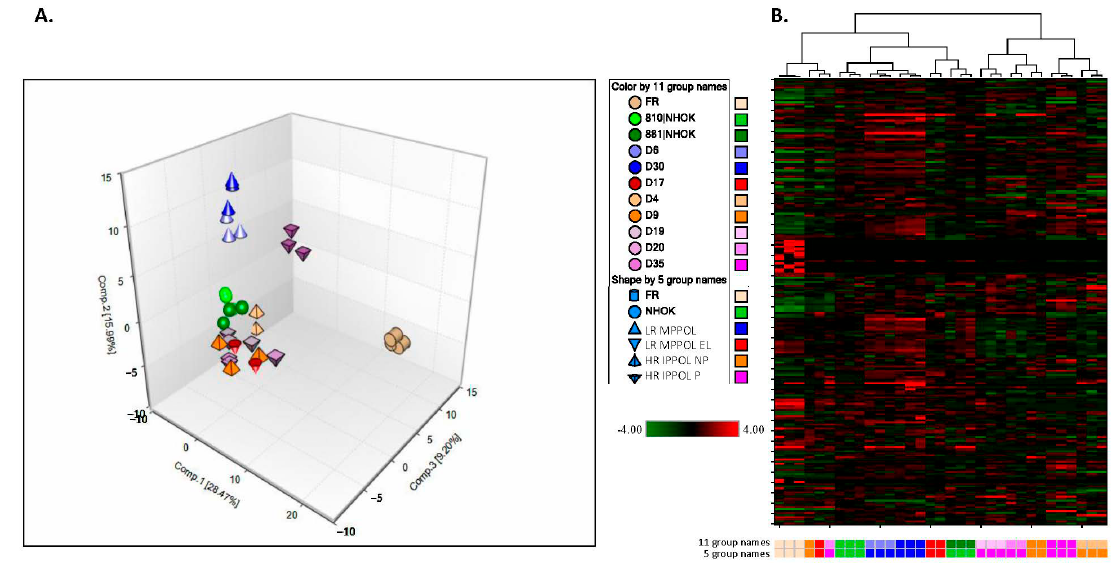
Figure 1. Principal component and cluster analysis of normal and PPOL keratinocyte extracellular metabolites. ( A ) Principal component analysis (PCA)—Low-risk mortal potentially premalignant oral lesion (LR MPPOL—D6 and D30), and rapidly progressing high-risk immortal potentially premalignant oral lesion (HR IPPOL P—D35) media samples exhibited significant separation from the other conditions analysed. The data from the individual cell lines and the fresh media (FR) are colour coded. The symbols represent into which group the individual lines are classified (normal human oral keratinocyte (NHOK—NHOK810 and NHOK881), LR MPPOL (D6 and D30), LR MPPOL extended lifespan (LR MPPOL EL—D17), HR IPPOL non-progressing (HR IPPOL NP—D4 and D9), or rapidly progressing (HR IPPOL P—D19, D20, and D35). The data show a clear separation of the LR MPPOL lines D6 and D30 (blue upright cones, circular base) and the HR IPPOL-P line D35 (dark purple inverted cones, square base) from the other groups and from each other. ( B ) Hierarchical clustering also consistently sorted the majority of the samples by cell class. The colour codes are the same as in (A). Interestingly, separation was observed between the normal keratinocyte groups NHOK810 (light green) and NHOK881 (dark green), the latter of which failed to reach confluence and appeared more